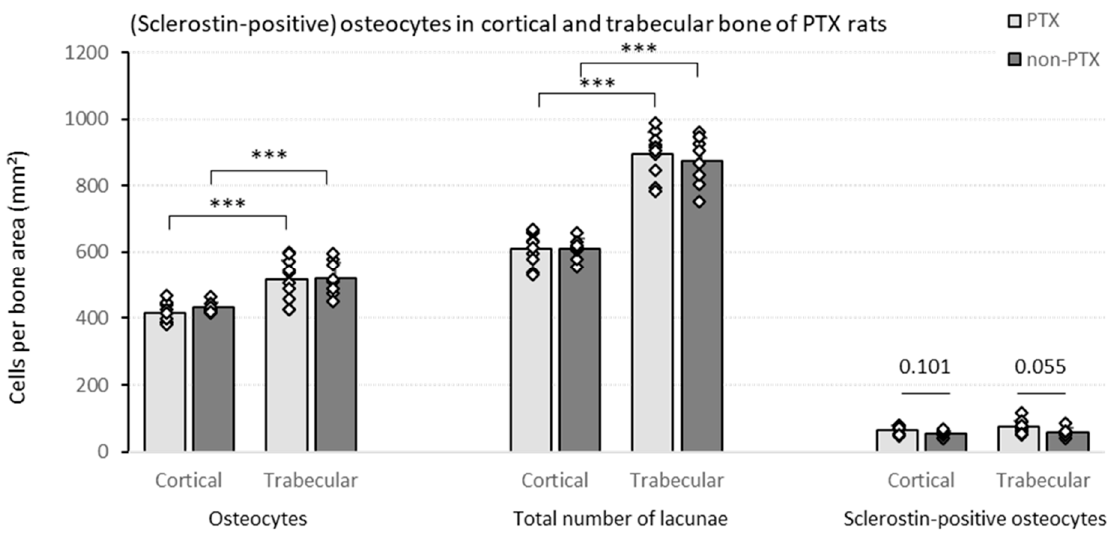
Figure 2. Cell counts in (non-)PTX RATS. Different cell counts (i.e., osteocytes, total number of lacunae and sclerostin-positive osteocytes) were determined in the cortical and trabecular bone of PTX rats ( n = 10) and non-PTX rats ( n = 9). Data shown as mean ± SD. *** p ≤ 0.001.